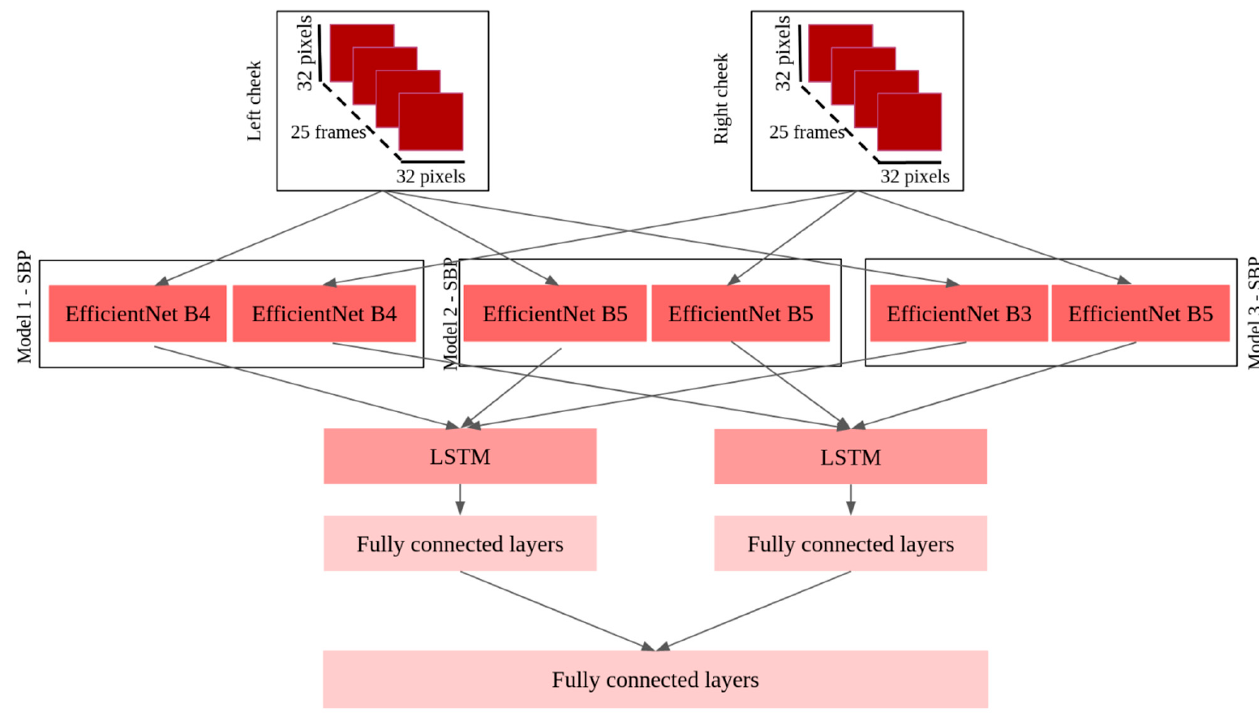
Figure 6. Architecture of the three best SBP models.